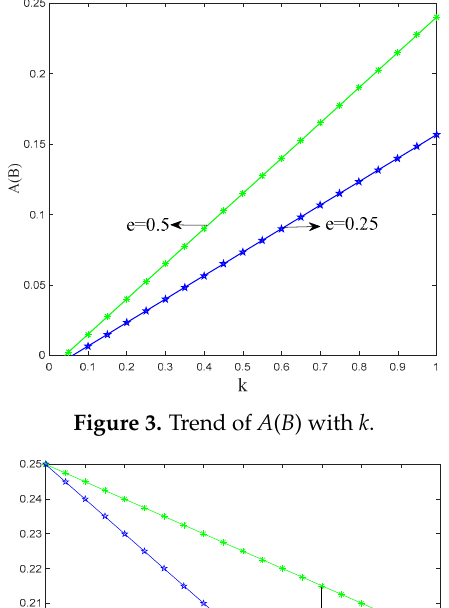
Figure 3. Trend of A ( B ) with k .